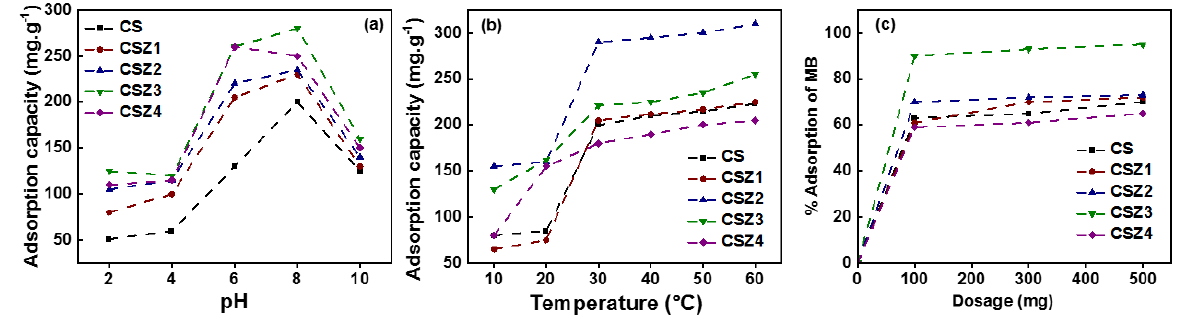
Figure 10. ( a ) Effect of pH ( b ) Temperature ( c ) adsorbent dosage on the adsorption of MO to chitosan/sodium zeolite adsorbents. Figure adapted from ref. [266].